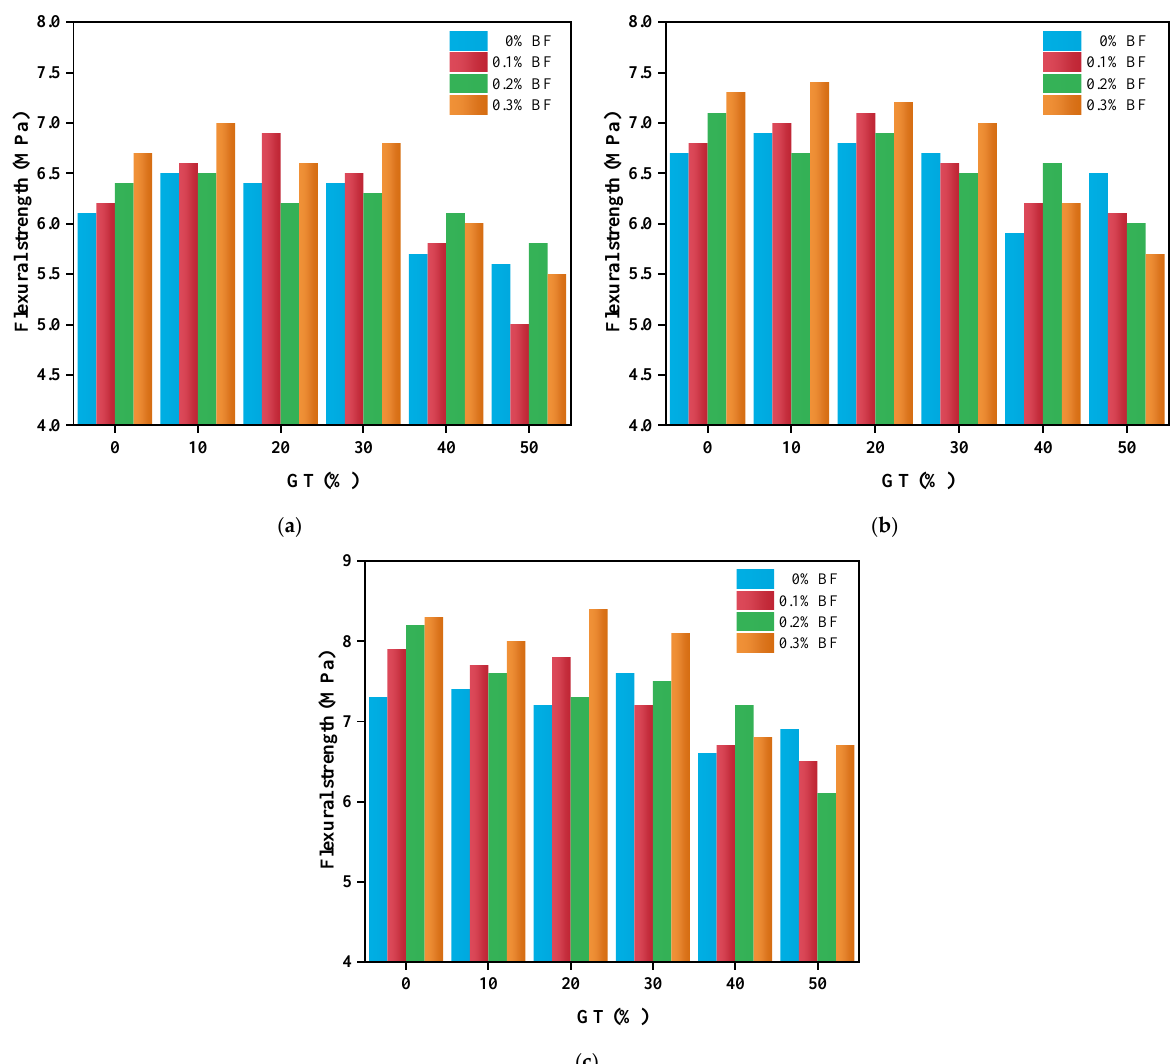
Figure 6. Test results of early age BFR-GTCM flexural strength: ( a ) flexural strength at 3 days of age; ( b ) flexural strength at 7 days of age; ( c ) flexural strength at 14 days of age.